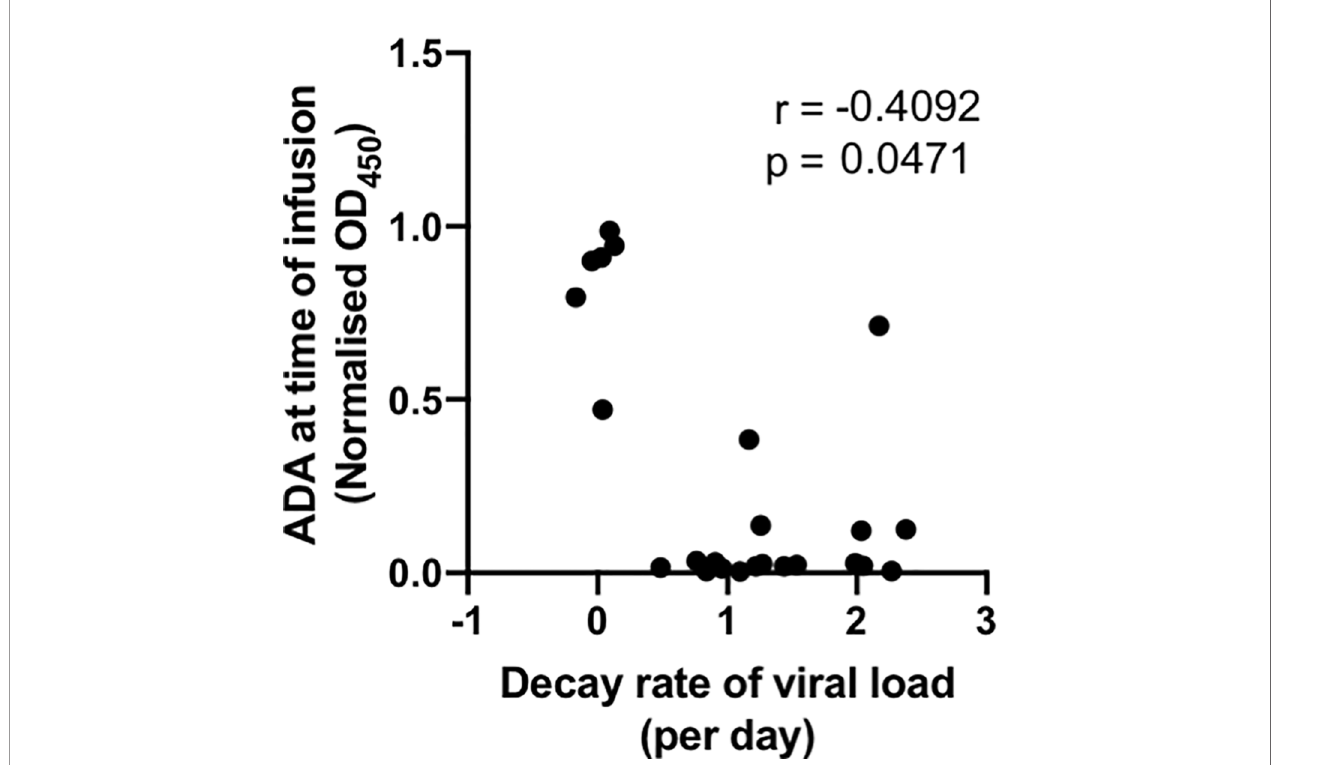
FIGURE 3 | ADA at time of infusion negatively correlates with viral suppression by PGT121. Macaques with active SHIV infection were administered PGT121 WT or LALA. Plasma viral loads were measured by digital droplet PCR at 0, 24, 36, 48 and 72 hours after PGT121 infusion and the decay rate within 72 hours was calculated using linear regression. The correlation was performed using a non-parametric spearman